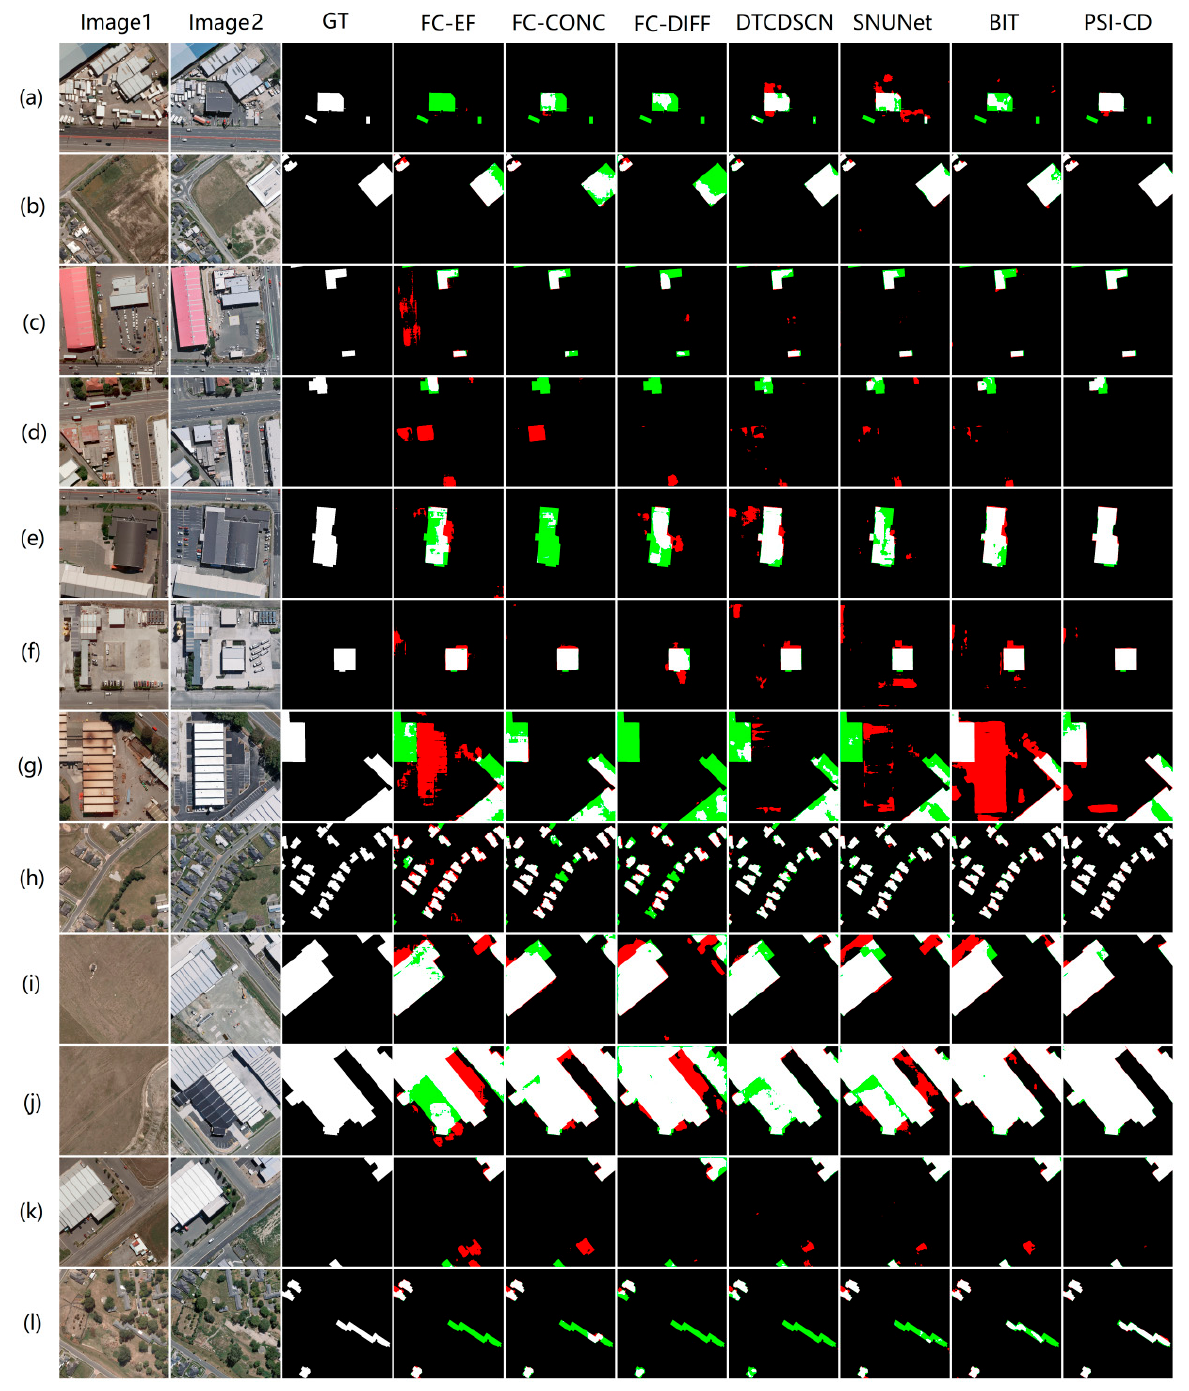
Figure 5. Experimental results of different methods on the WHU dataset. ( a – l ) are different types of building change detection results on the WHU dataset. White, black, red, and green represent true positive, true negative, false positive, and false negative, respectively.